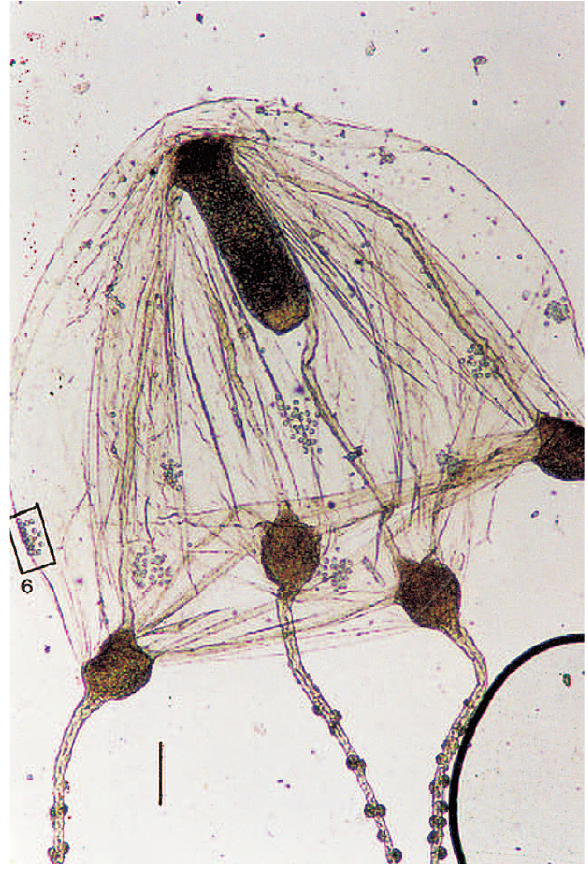
Figure 6a. Scale =